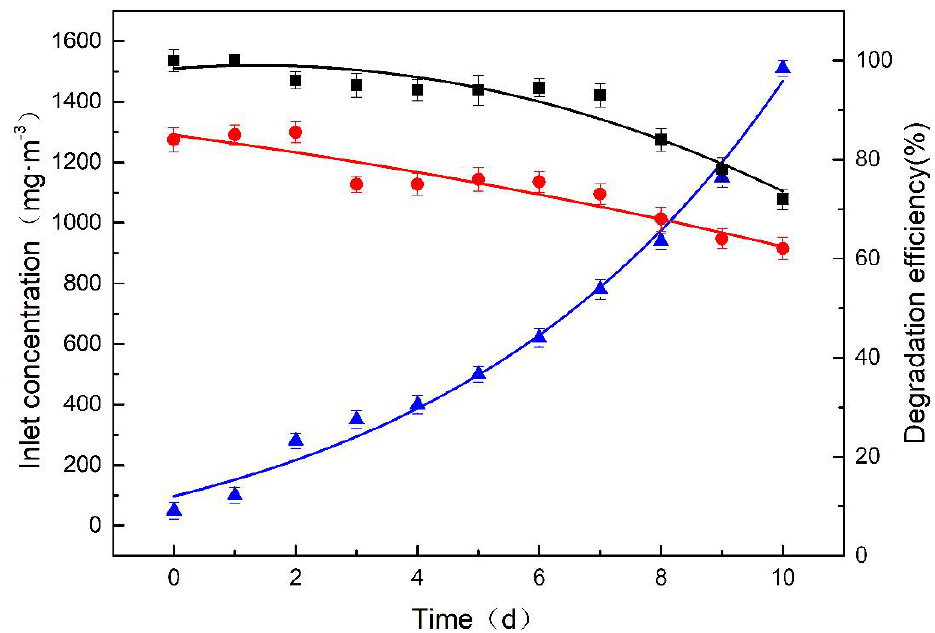
Figure 8. Comparison of chlorobenzene degradation between the integrated system and BTF only (● Degradation efficiency of a single biofilter system, ▲ Imported chlorobenzene concentration, ■ Degradation efficiency of integrated system) (cycling solution density = 10.36 L (m −3 ·s −1 ), oxygen concentration = 10%, input voltage = 7 kV, HRT of the BTF = 85 s, HRT of the DBD = 5.5 s.).